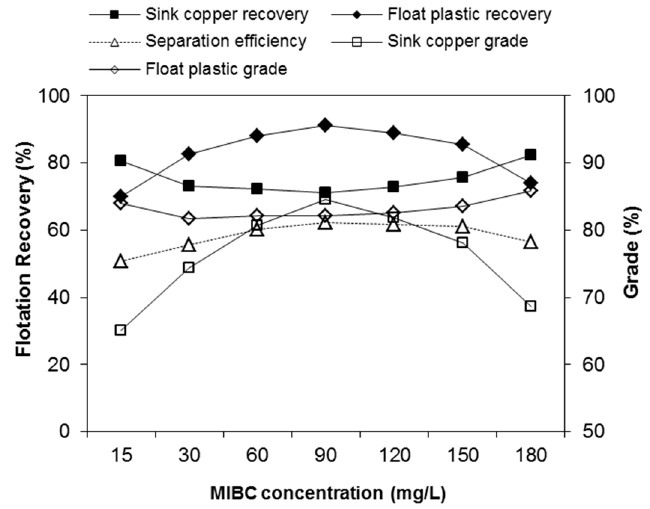
Figure 2. Recovery and grade of copper in the sink and of plastic in the floated, and separation efficiency versus MIBC concentration.